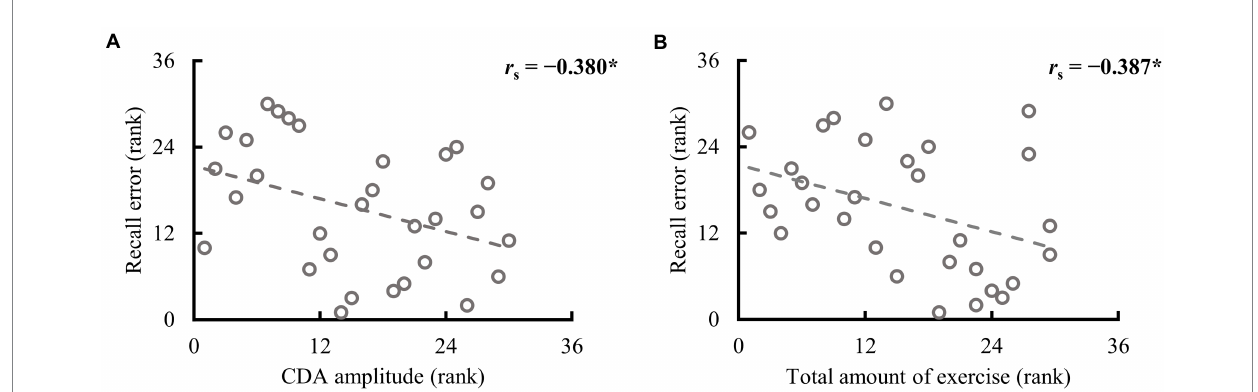
FIGURE 4 Spearman correlation between recall error in the valid cue condition and CDA amplitude and the total amount of exercise in the full sample ( n = 30). (A) The higher the rank is, the larger the CDA amplitude and recall error. (B) The higher the rank, the larger the total amount of exercise and recall error. * p < 0.050.